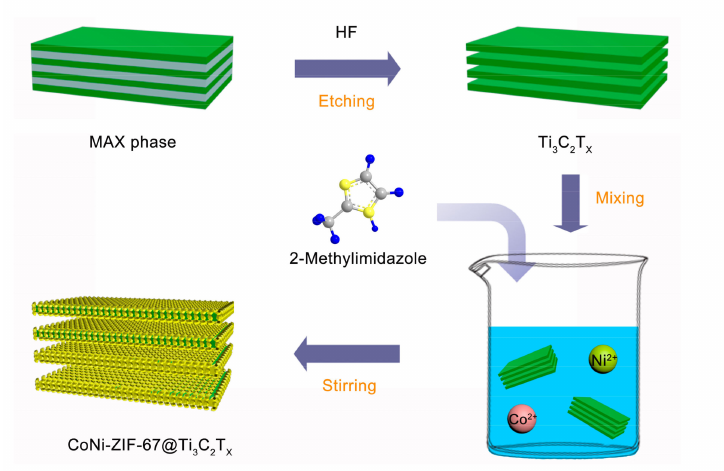
Figure 1. Schematic illustration of the preparation of CoNi-ZIF-67@Ti 3 C 2 T x